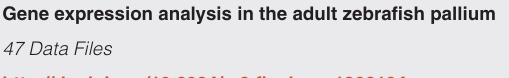
Figure 2. Expression of emx1 , emx2 and emx3 in the pallium. A . At the anterior commissure (Cant), emx1 expression is found in neuronal layer (nl) and ventricular zone (vz) of Dp. B . Caudal to Cant, emx1 expression is present in the vz and nl of Dp and in EN. C . Caudal to Cant, emx2 expression is present in part of Dc. D .– F . Summary of the expression pattern of emx1 and emx2 at commissural ( D .) and postcommissural levels ( E ., F .). G . In the rostral telencephalon, emx3 expression is present in the vz and nl of Dm, weakly in scattered cells of the nl od Dc and in the vz of Dlv (arrowheads). H . At mid-telencephalic levels, emx3 expression is found in the vz and nl of Dm, in scattered cells in Dc, and in the vz and nl of Dlv. I . At Cant, emx3 expression is present in the vz and nl of Dm, in scattered cells in Dc and in the vz and nl of Dp. J .– L . Summary of the expression pattern of emx3 at rostral ( J .), mid-telencephalic ( K .) and commissural levels ( L .). A .– F . Brightfield images of cross-sections at the levels indicated through the telencephalon. Red dashed line indicates subdivisions based on the current marker. White dashed line indicates subdivisions based on other markers. The black dashed line indicates the boundary between D and V. Scale bars = 50µm in A – D . Expression of ascl1a in the adult zebrafish pallium Gene expression analysis in the adult zebrafish